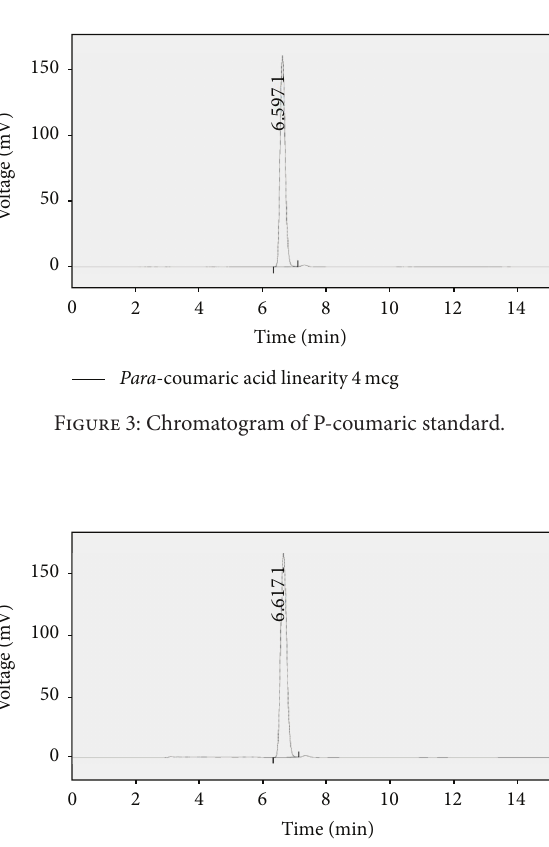
y = 449.51x + 4.7619 R 2 = 0.9991